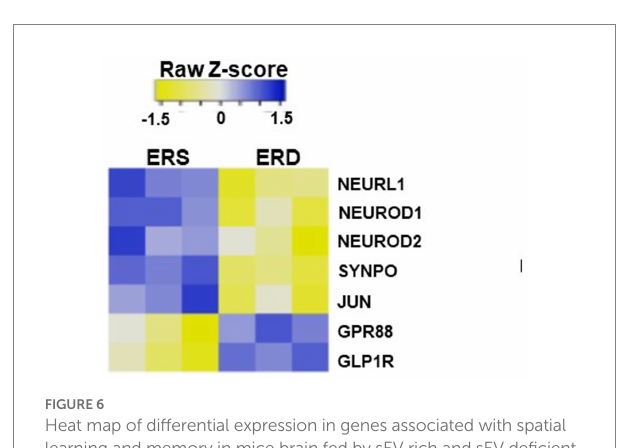
FIGURE 6 Heat map of differential expression in genes associated with spatial learning and memory in mice brain fed by sEV rich and sEV deficient